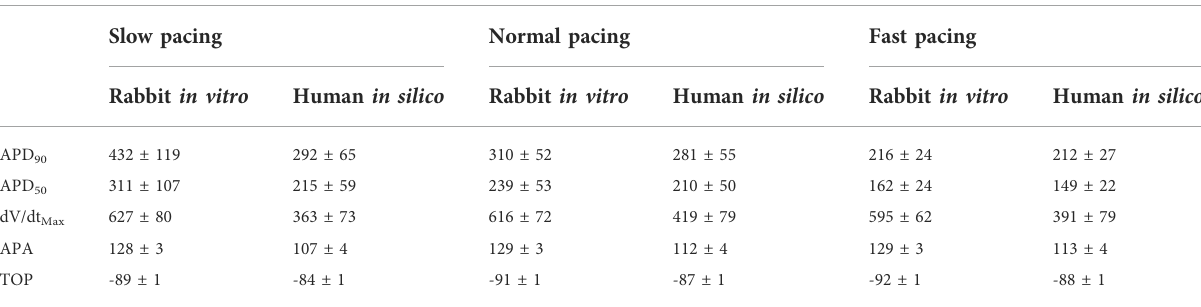
TABLE 2ExperimentalandsimulatedAPbiomarkers in controlconditions (no drug)at slowpacing (0.25), normal pacing (1 Hz)andfastpacing (3 Hz).